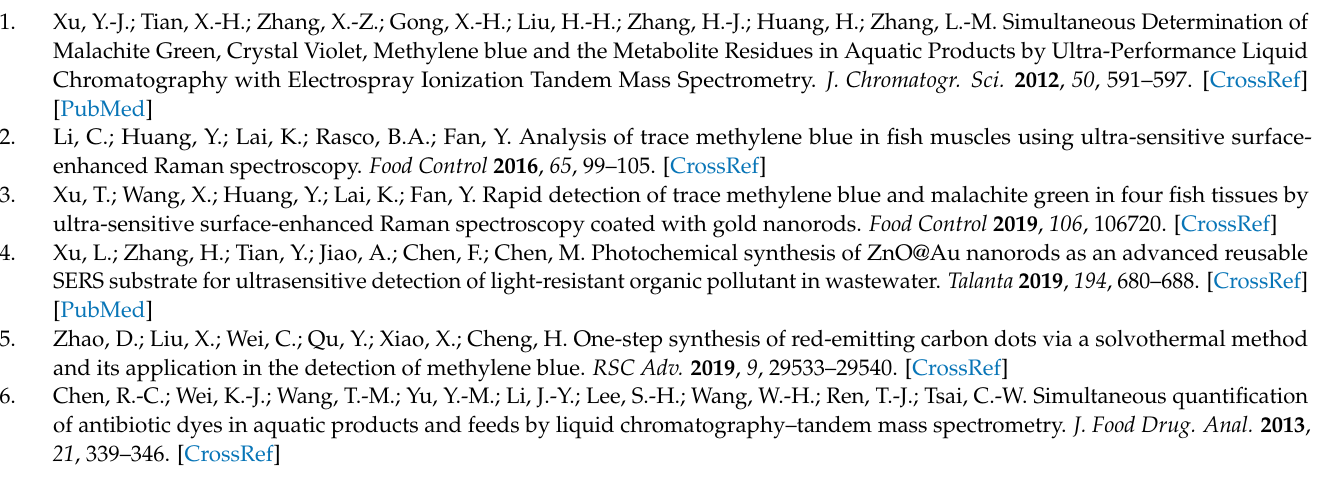
stripe. Figure S2. (a) Results of particle size statistics of AuNPs. (b) SEM images of the CFP@PDA (black) for 15 µ L 10 − 9 M 4-ATP on 36 mm 2 of CFP@PDA@AuNPs and the Raman spectrum (red) for 10 − 2 M 4-ATP on a 110 mm 2 silicon wafer. Table S1. Assignments of major peaks for methylene blue (MB). Figure S5. Raman spectra of lake water (red) and SERS spectra of 10 − 5 M MB